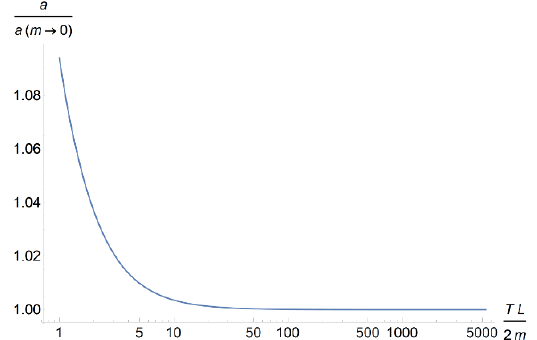
Figure 6 . The contribution to the intercept of the rotating string as a function of TL from the planar mode. The intercept is normalized by the value at m ! 0, which is 1